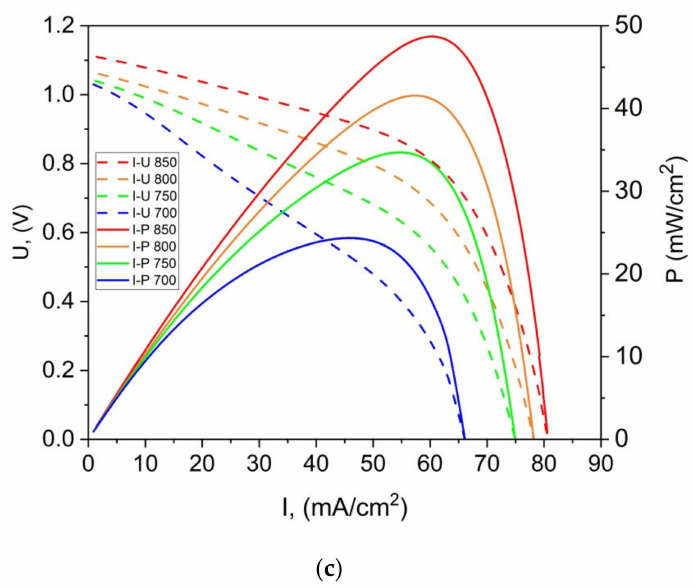
Figure 15. ( a ) Families of dependencies: voltage U–current density I and power density P vs. current density I, as determined for DC-SOFC (I) with a lanthanum-strontium-manganite (LSM) cathode and N 2 atmosphere over a solid fuel (P0). Temperature range was 700–850 ◦ C. ( b ) Families of dependencies: voltage U-current density I and power density P vs. current density I, as determined for DC-SOFC (I) with LSM cathode and N 2 atmosphere over solid fuel (P300). Temperature range was 700–850 ◦ C. ( c ) Families of dependencies: voltage U-current density I and power density P vs. current density I, as determined for DC-SOFC (I) with LSM cathode and N 2 atmosphere over solid fuel (P300). Temperature range was 700–850 ◦ C.